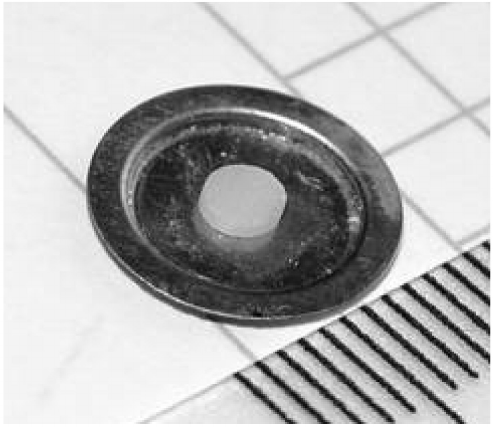
Figure 1. An exemplary LiMgPO 4 (LMP) crystal grown from melt using the micro-pulling-down method. The crystal was placed on a stainless steel cup that held the sample during luminescence measurements inside the Risø TL / OSL DA-20